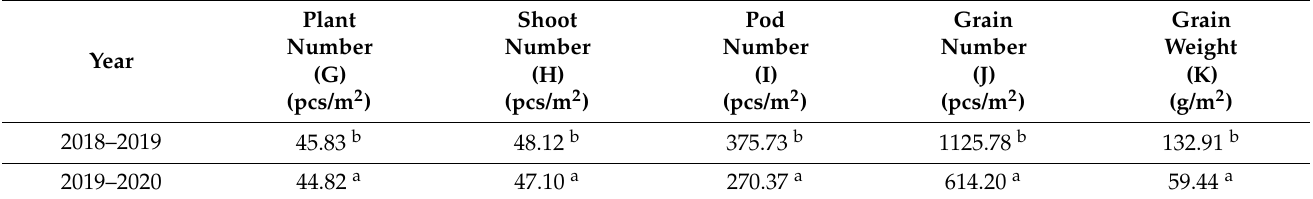
Table 14. Changes in winter pea ( Pisum sativum L.) yield components (G, H, I, J, K) in the study